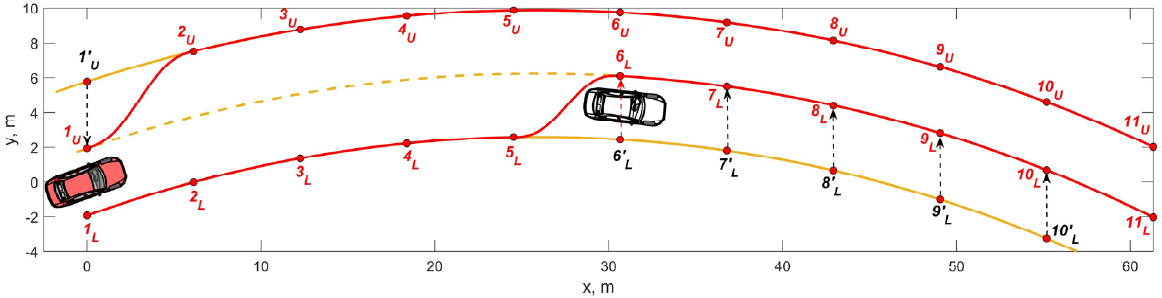
Figure 3. Forming the boundaries of the allowable area before planning a maneuver. Initial Position. At the initial time, the AV’s mass center position corresponds to the coordinates (0, 0) in the xy system, and the yaw angle differs little from the average slope of the tangents in the nodes of closest marking lines along the vehicle sides. To increase vehicle behavior stability and limit maneuver variations near the initial position, it is nec- essary to lock the outer boundaries’ initial nodes on the nodes of adjacent marking lines, contributing to forming an entry corridor, as shown in Figure 3 regarding node 1. In this case, the three interpolation parameters in the node 1 ’ U of the outer border are replaced by the corresponding DOF of the node 1 U of the dividing marking line. As seen, this also ensures a smooth transition of the boundary between the 1 U and 2 U nodes. In this case, the lower boundary node 1 L has already been defined; however, in the case, for example, of this node as well.